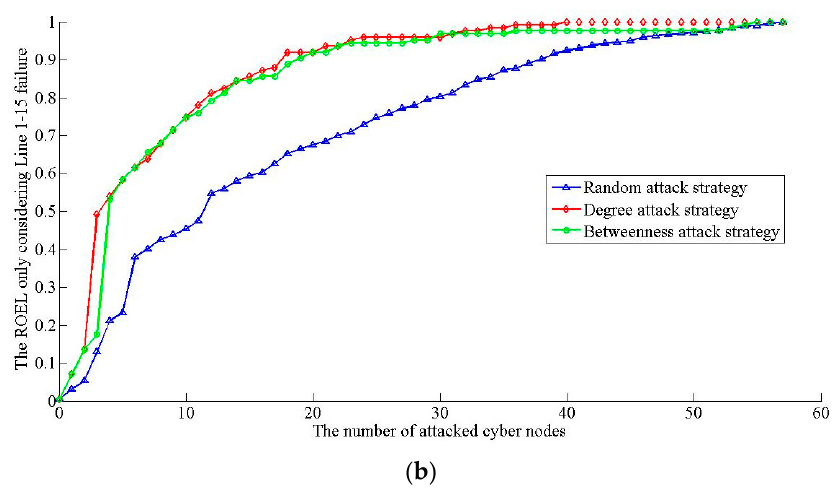
Figure 3. Under different attack strategies, the vulnerability indices of CPPS only considering Line 1–15 failure: ( a ) ROLL; ( b ) ROEL.